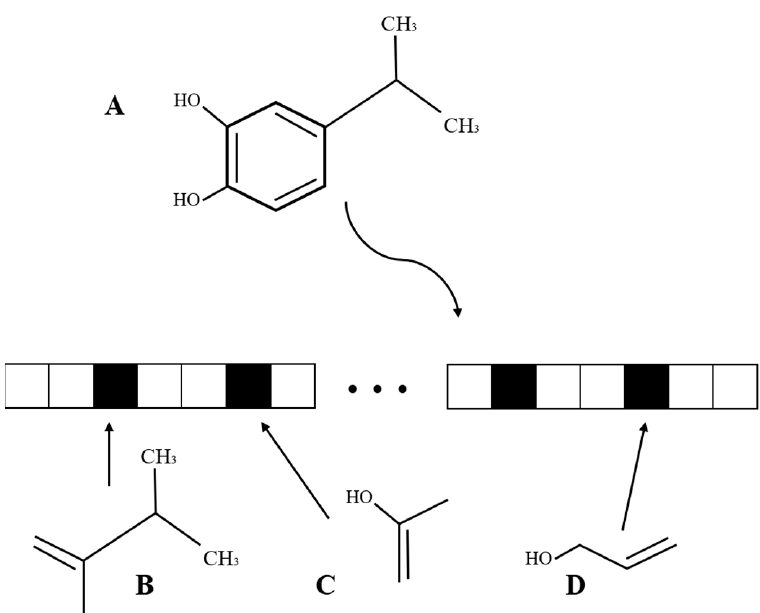
Figure 1. A schematic diagram of the drug molecular structure is constructed as bit vectors. A is the structure of a drug molecule, and B, C, and D are all substructures of the drug molecule, corre- sponding to the converted bit (represented by the small black box), respectively.